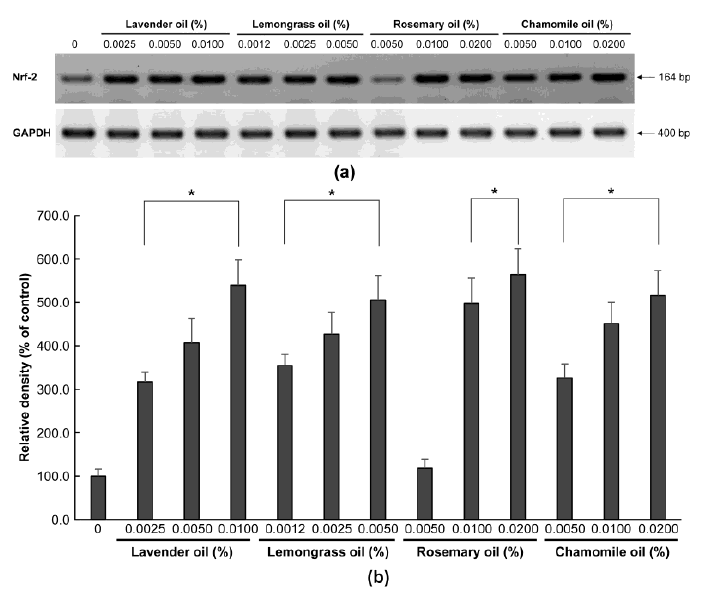
Figure 2. Dose-dependent induction of NRF-2 mRNA expression in essential oils-treated DPC. ( a ) The DPCs were treated with lavender oil (0.025–0.01%), lemongrass oil (0.0012–0.005%), rosemary oil (0.005–0.02%), or chamomile oil (0.005–0.02%). GAPDH was used as an internal standard to quantify